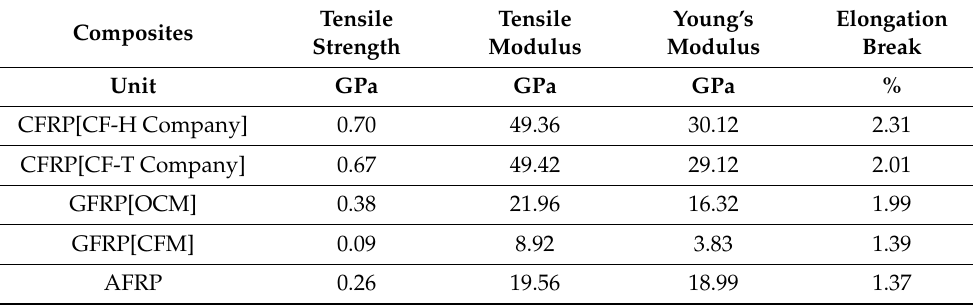
Table 2. Tensile strength and Young’s modulus of the hand lay-up molded